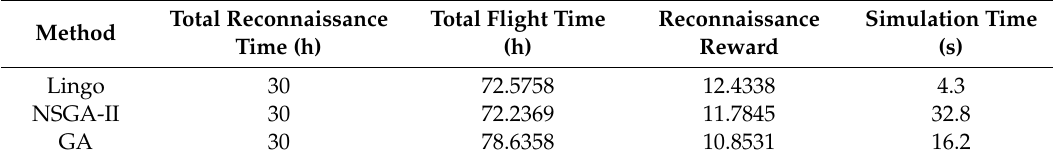
Figure 8. Five simulation data for three methods. Table 2. Results of the three methods. Table 3. Results of the three methods.